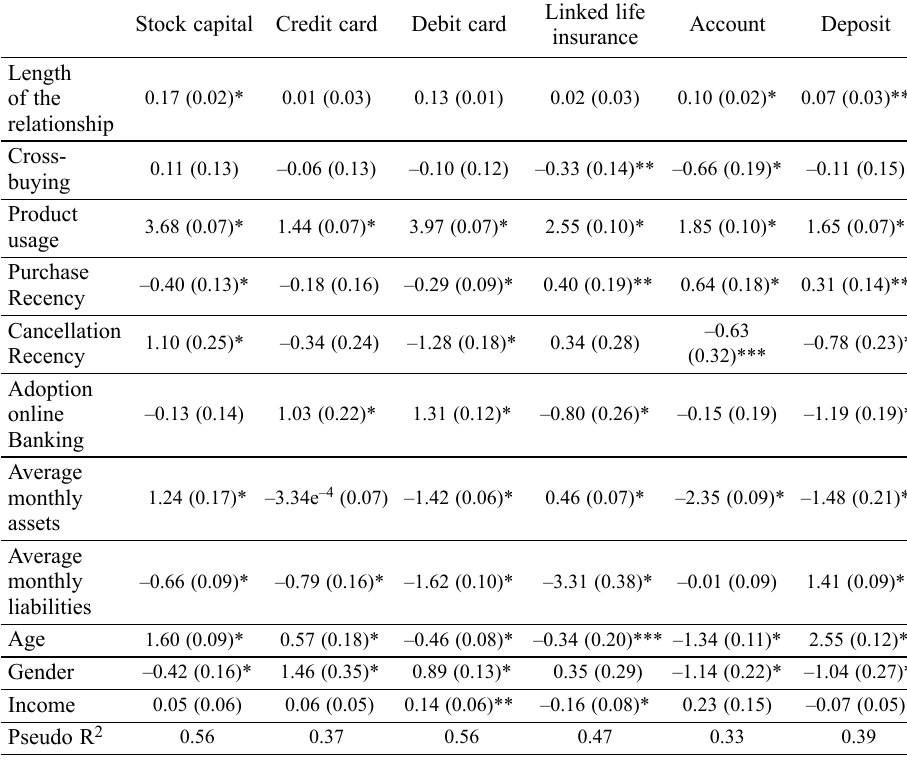
Table 3. Parameter estimates for univariate Probit models (Coefficient (standard error))